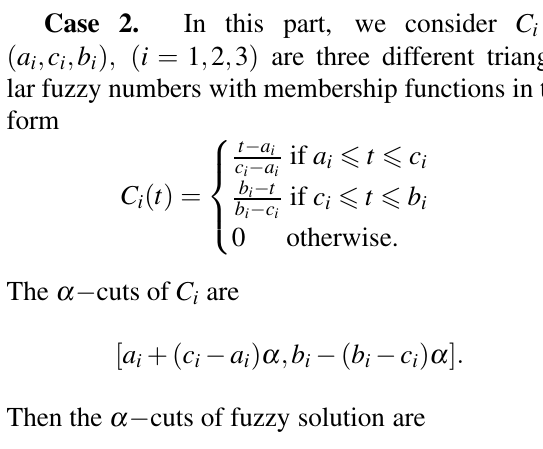
Fig. 10. The surface of fuzzy solution with triangular fuzzy numbers C i , i = 1 , 2 ,